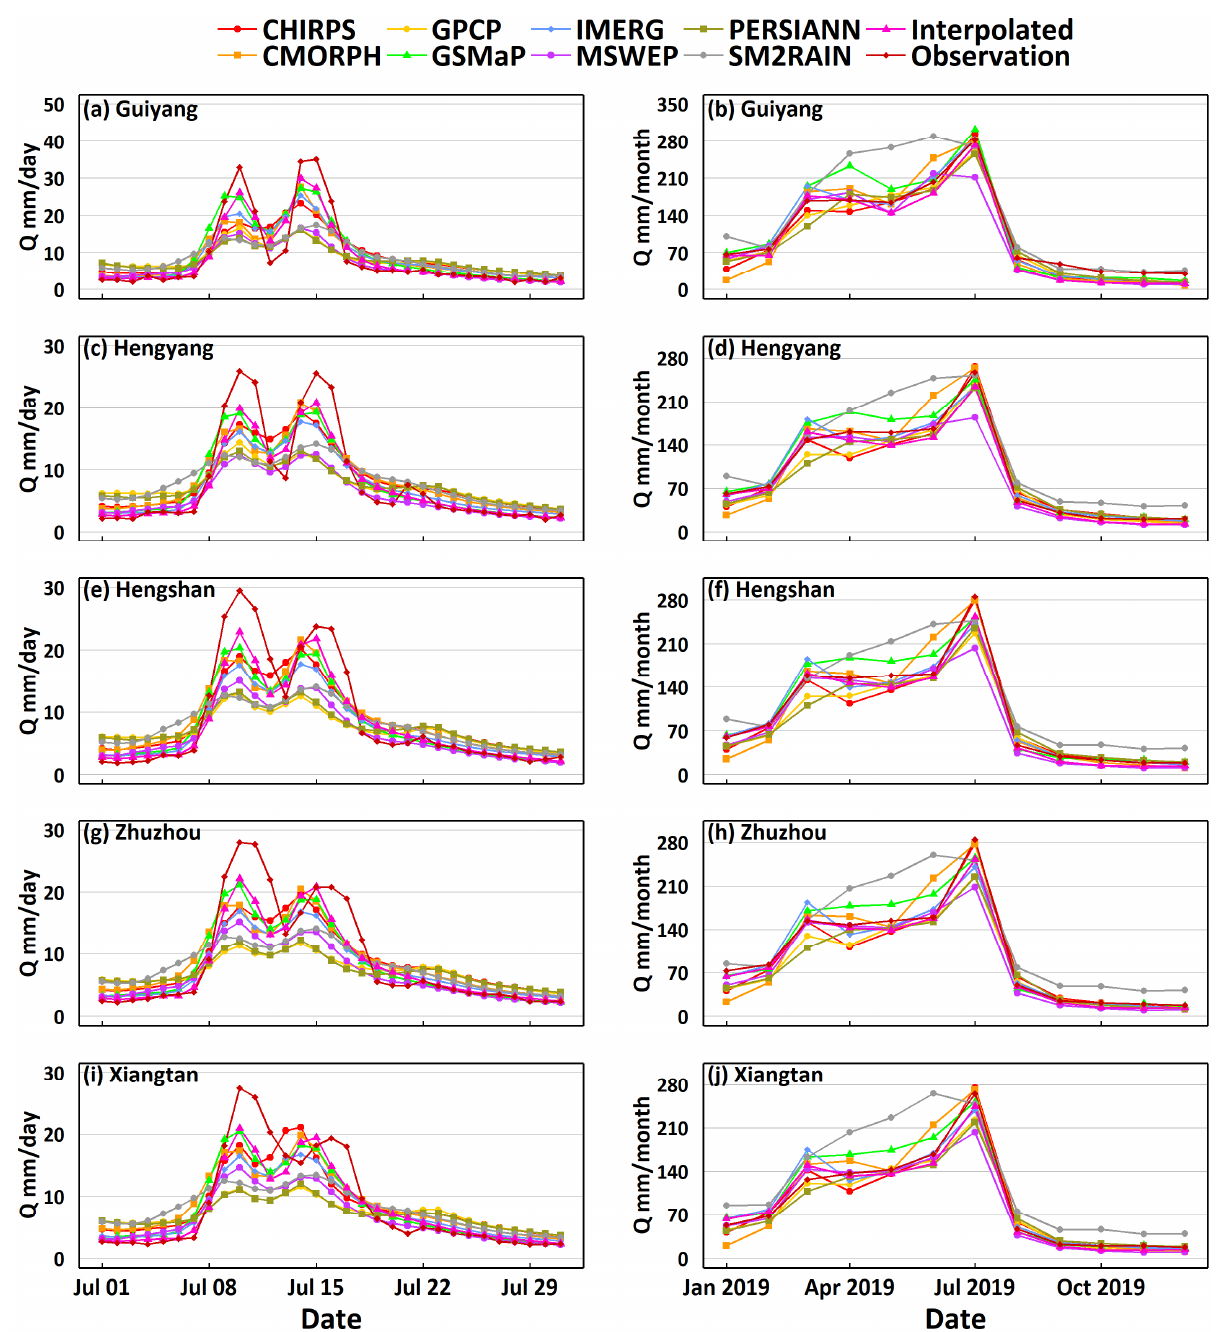
Figure 8. Observed and average modelled discharge (Q, mean for four hydrologic models) for different precipitation inputs and sub-basins in hydrologic modelling. Different coloured lines present each precipitation input with marks.